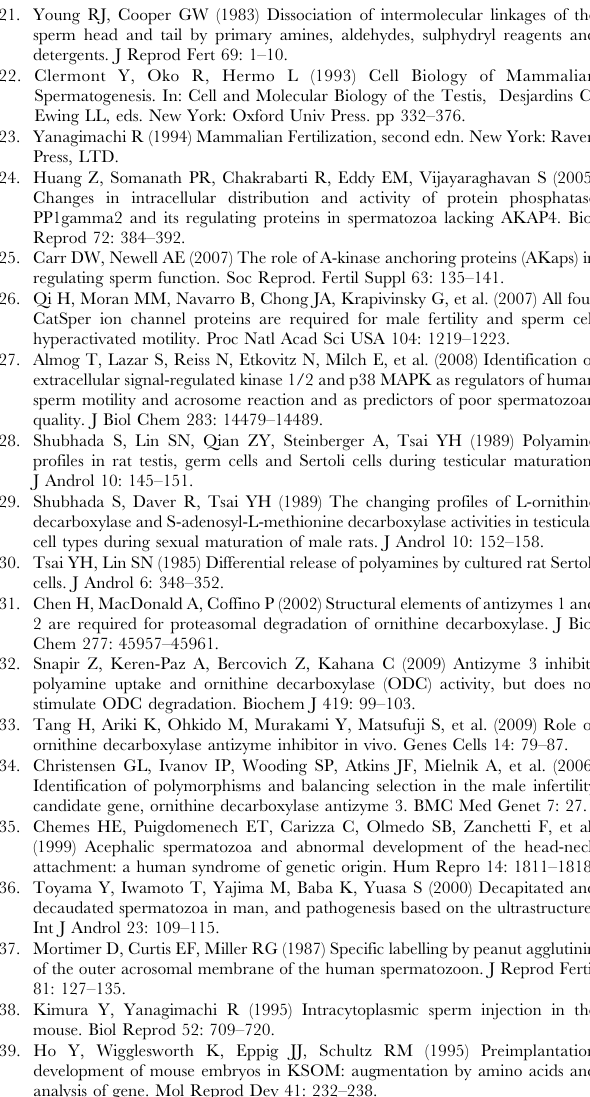
The OAZ-t null sperm were separated easily into heads and flagella, and the headless sperm swam